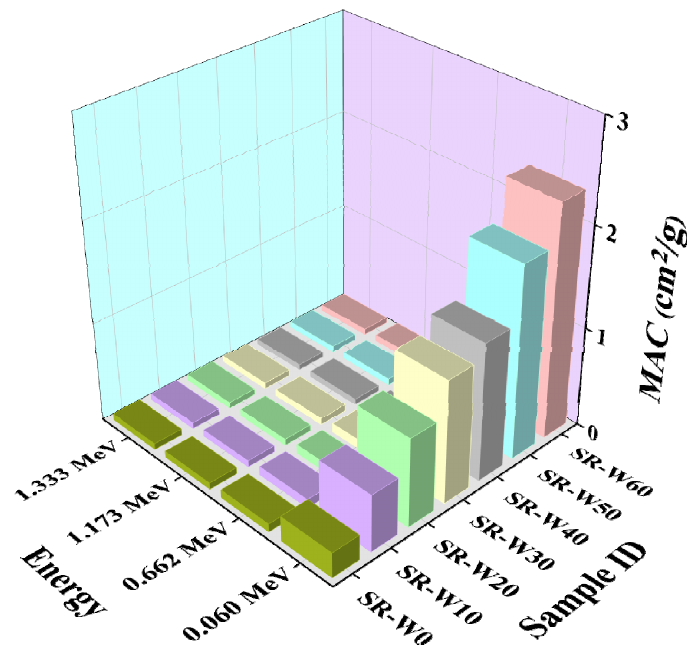
Figure 10. Pictorial presentation of the MAC of prepared silicone rubber (SR-W) systems with the function of